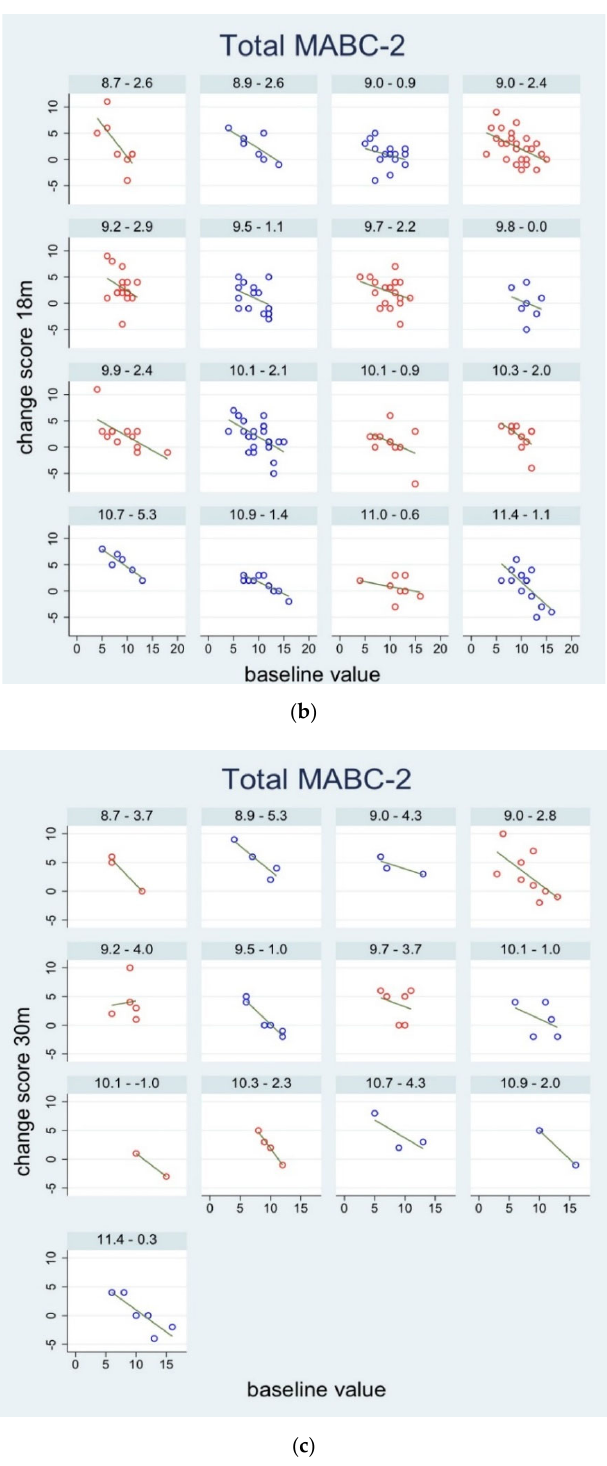
Figure 3. Scatter plots of change scores for the MABC-2 total score at the three follow-up times (( a ) for 6 months follow-up, ( b ) for 18 months follow-up, and ( c ) for 30 months follow-up) vs. baseline values for each child, stratified by preschool. For each pre-school, a regression line is fitted. Preschools from the intervention group are shown in red and preschools from the control group are shown in blue. In the top of each subgraph, the mean baseline value and the mean change score are shown for each preschool. The preschools are sorted by the mean value at baseline. MABC-2: Movement Assessment Battery for Children, version